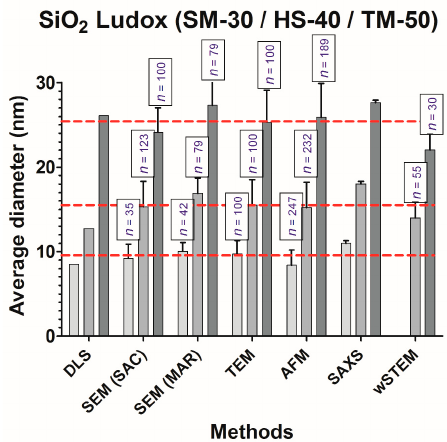
Figure 4. Size measurement of three monodisperse solution of SiO 2 nanoparticles (Ludox). Measurements were performed with Dynamic Light Scattering (DLS), Scanning Electron Microscopy (SEM), Transmission Electron Microscopy (TEM), Atomic Force Microscopy (AFM), Small-Angle X-ray Scattering, and liquid Scanning Transmission Electron Microscopy (wet-STEM). Results on Ludox SM30/HS40/TM50 are shown in light/medium/dark gray colors, respectively. The red dashed lines correspond to the average values of all the applied methods: 9.3 ± 1.5 nm for SM30, 15.6 ± 2.6 nm for HS40, and 25.4 ± 2.9 nm for TM50. n represents the number of measurements obtained in each method. Two silver (Ag) nanoparticles were selected: NM-300K and PVP. Ag NM-300K is a European reference material where 99% of NM-300K particles have a size less than 20 nm, while 1% is above 20 nm [49]. Polyvinylpyrrolidone (PVP) is a surfactant that allows a greater dispersion of silver particles; the PVP-coated silver NPs do not have a reference size but it was measured previously at 59 ± 18 nm [47] using TEM. Images of both silver nanoparticles are shown in Figure 5 and size measurements are summarized in Figure 6. More than 99% of all silver NPs have a size <100 nm (Table S1).